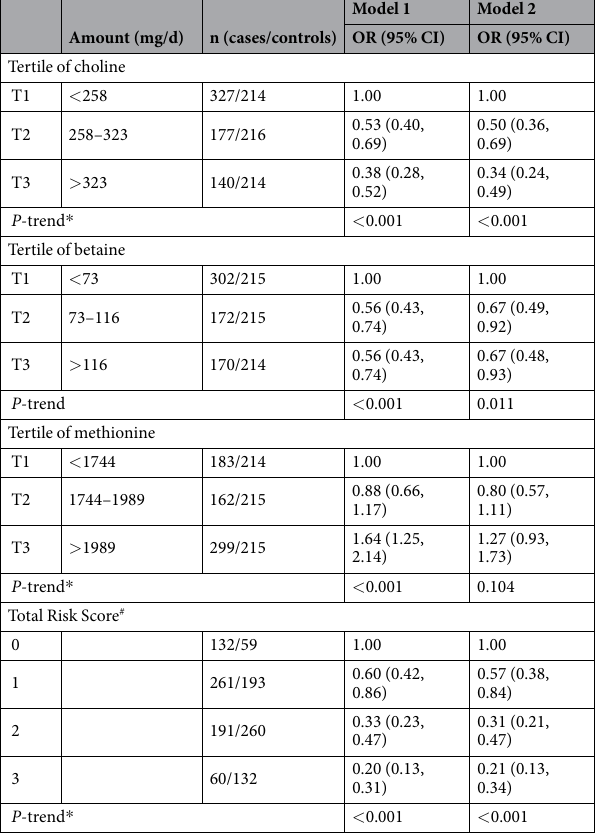
Table 2. Odds ratios (ORs) and 95% confidence intervals (CIs) of primary liver cancer according to the tertiles of total choline, betaine, methionine intake and total risk score. Models 1 and 2: from the conditional logistic model. Model 1: adjusted for the daily energy intake (ln-transformed), in addition to matching by sex and age. Model 2: Model 1 + , BMI, education level, occupation, household income, smoking, alcohol consumption, tea consumption, physical activity and dietary folate intake. The covariates were selected for their theoretical importance as confounders. * α for p-trends = 0.05/6(tests) = 0.0083. # Summing the scores of each nutrient of choline (0 = < median, 1 = ≥ median), betaine (0 = < median, 1 = ≥ median), and methionine (0 = quartile 1 and 4, 1 = quartile 2 and